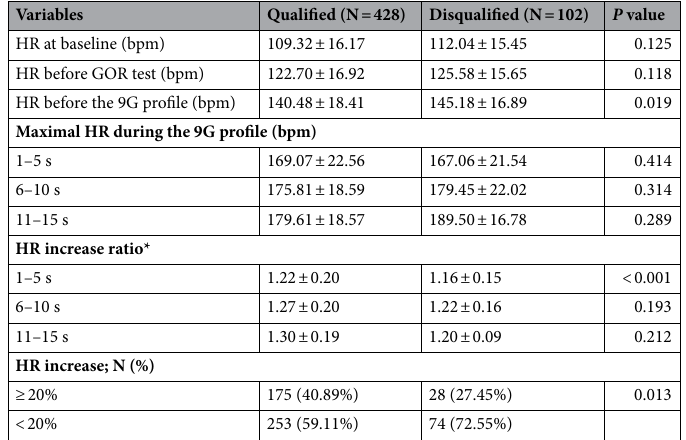
Table 3. HR changes at different stages of training. N number, HR heart rate, GOR gradual onset rate. *Maximal HR during the initial 1–5 s of the 9G profile divided by HR before the 9G profile.